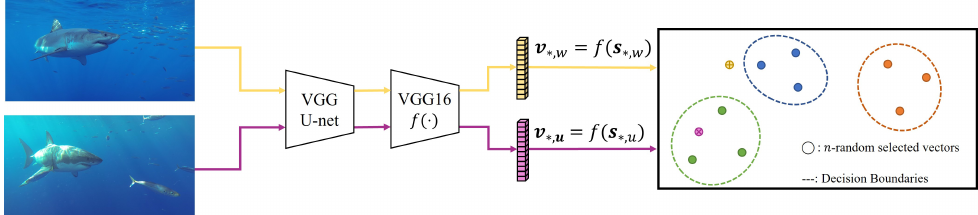
Figure 4. Illustration of the shark recognition process using the trained model. The image of a shark s ∗ , u is recognized as the ‘green’, but the image s ∗ , w is not